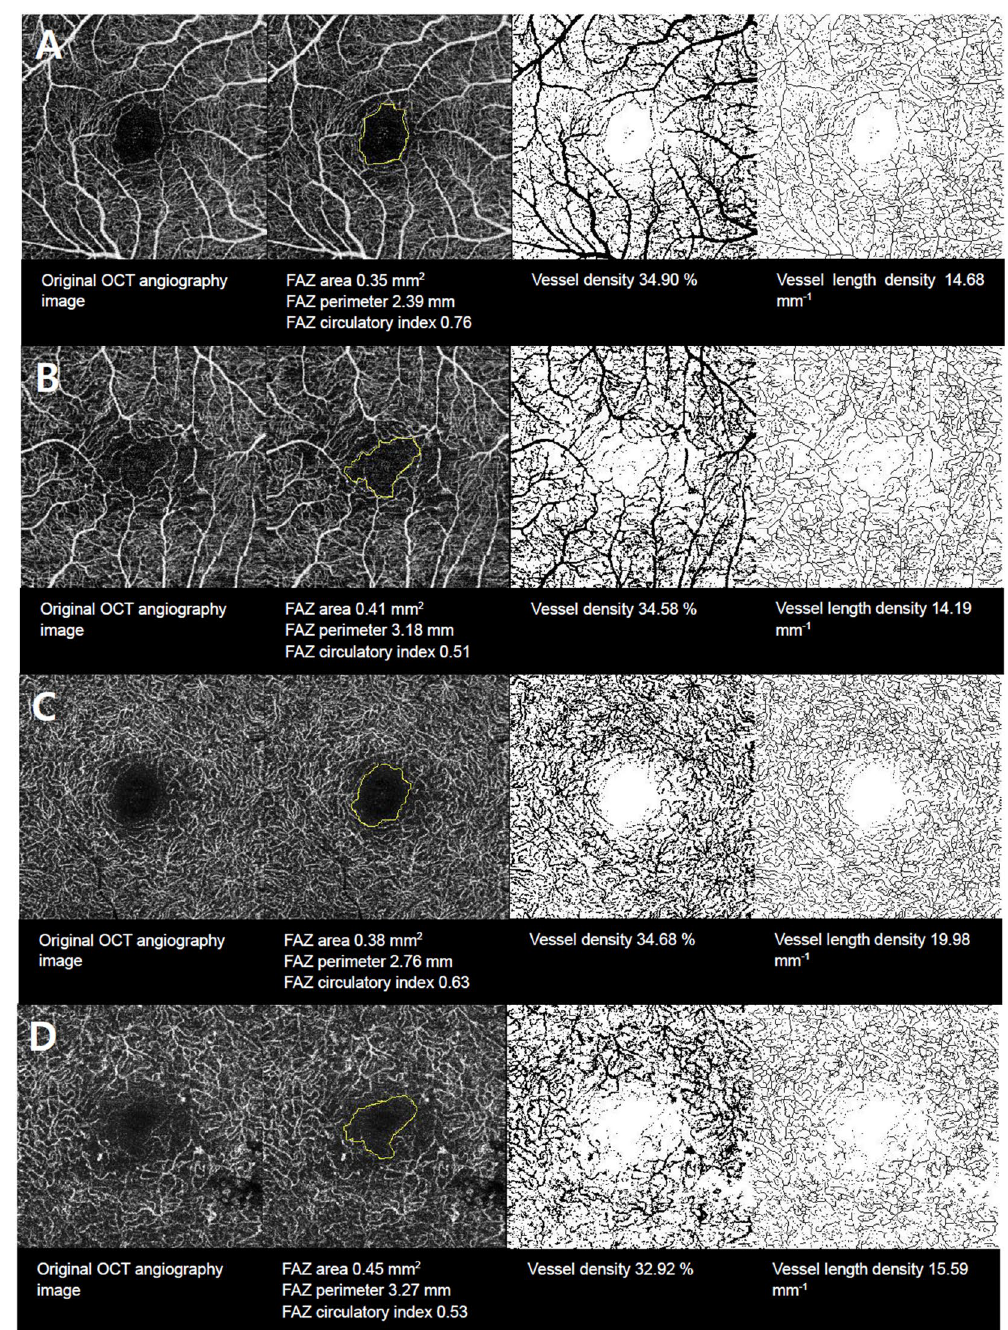
Figure 2. Representative en face optical coherence tomography(OCT) angiography images demonstrate visualization of ( A ) the superficial retinal capillary plexus with no diabetic retinopathy (DR), ( B ) the superficial retinal capillary plexus in proliferative DR (PDR), ( C ) the deep retinal capillary plexus with no DR, and ( D ) the deep retinal capillary plexus in PDR. Notes: FAZ, foveal avascular